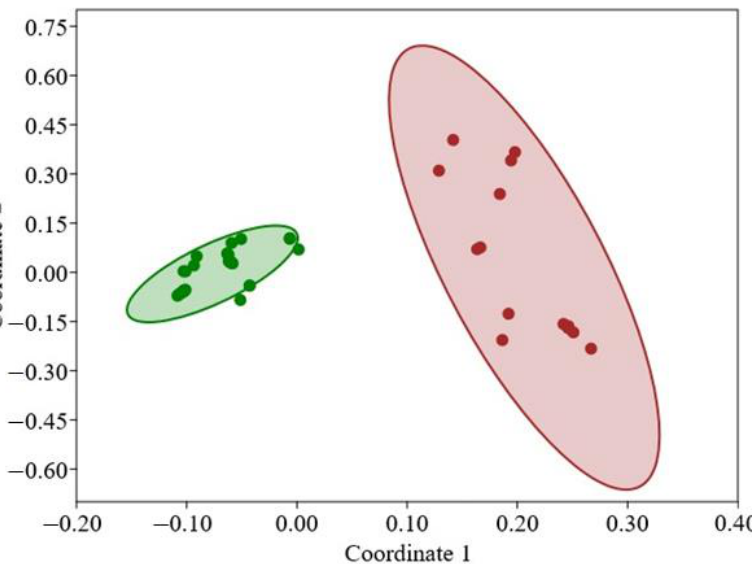
Figure 4. The results of the PCoA of the COI sequence datasets from sub-lineages EUR1 (green) and EUR2 (red). EUR2